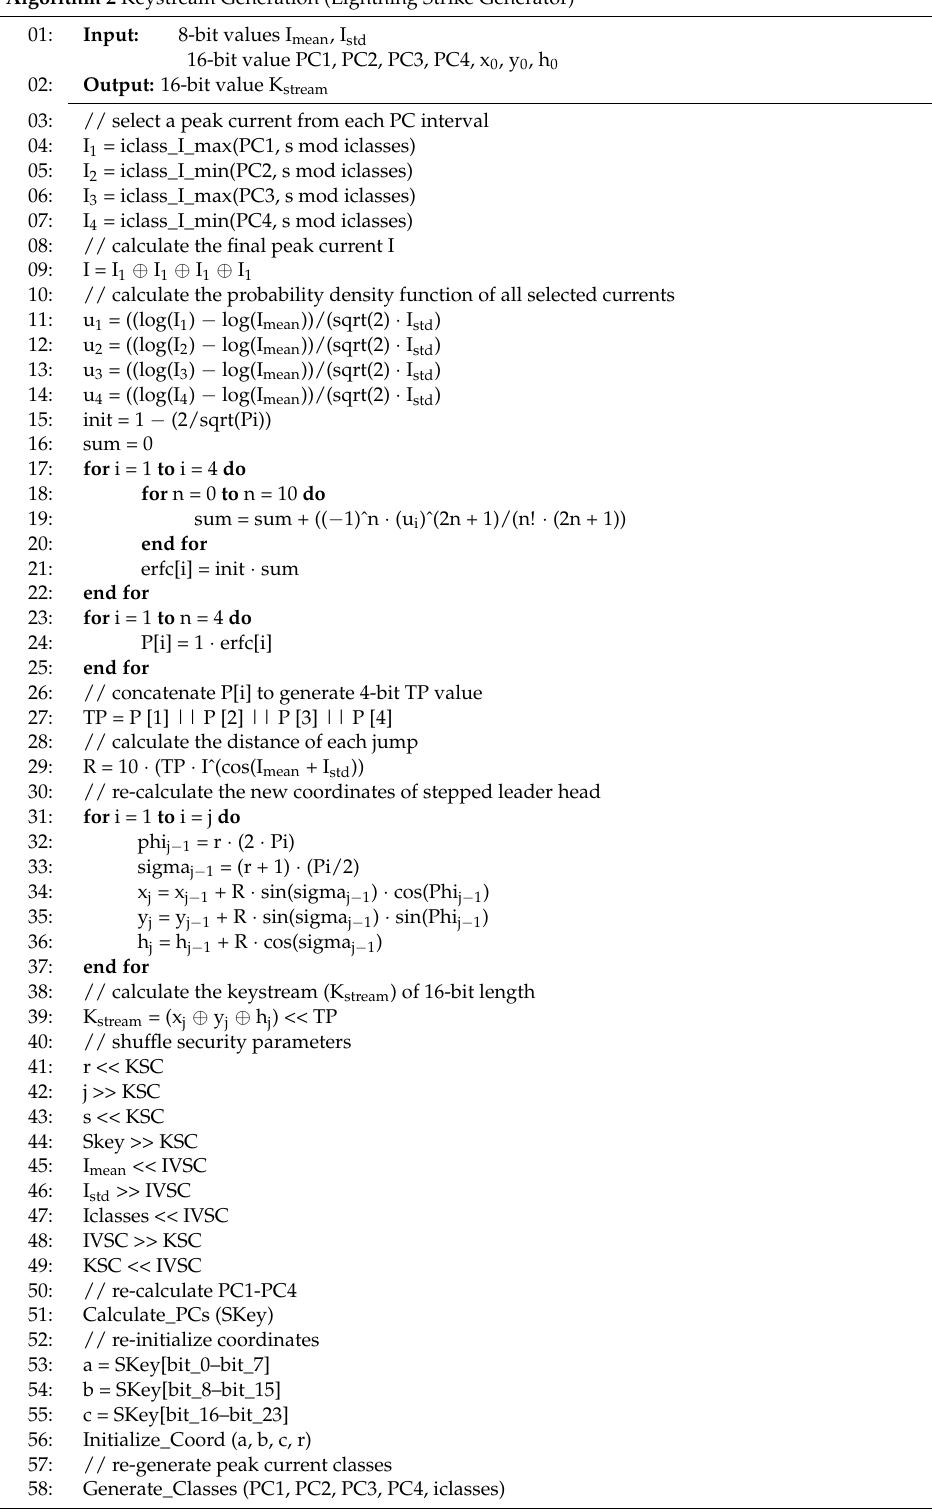
Algorithm 2 Keystream Generation (Lightning Strike